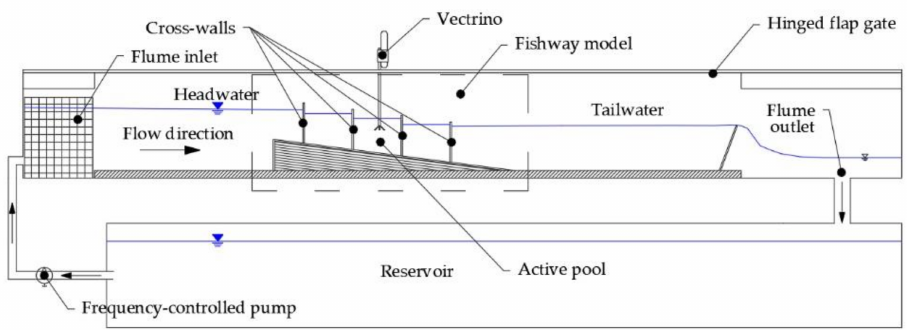
Figure 2. Scheme of the physical model setup in the hydraulic